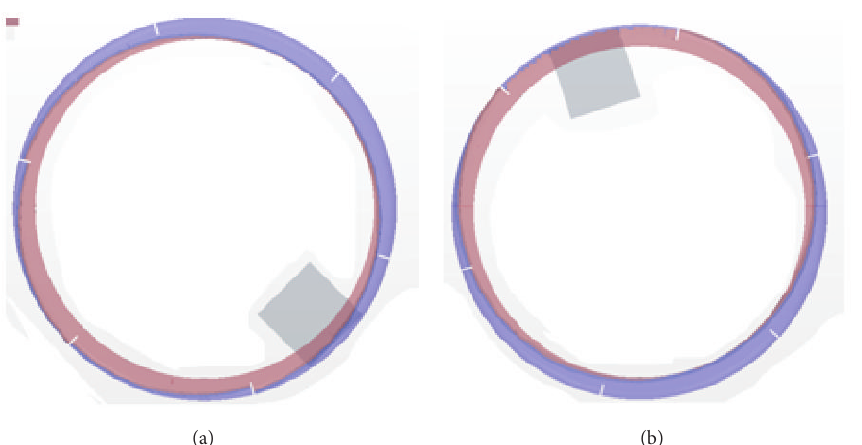
Figure 8: Representation of balance ring water distribution for 10 mm eccentricity and 500 rpm rotation, where (a) is 90 ∘ phase angle and (b) is 180 ∘ phase angle.